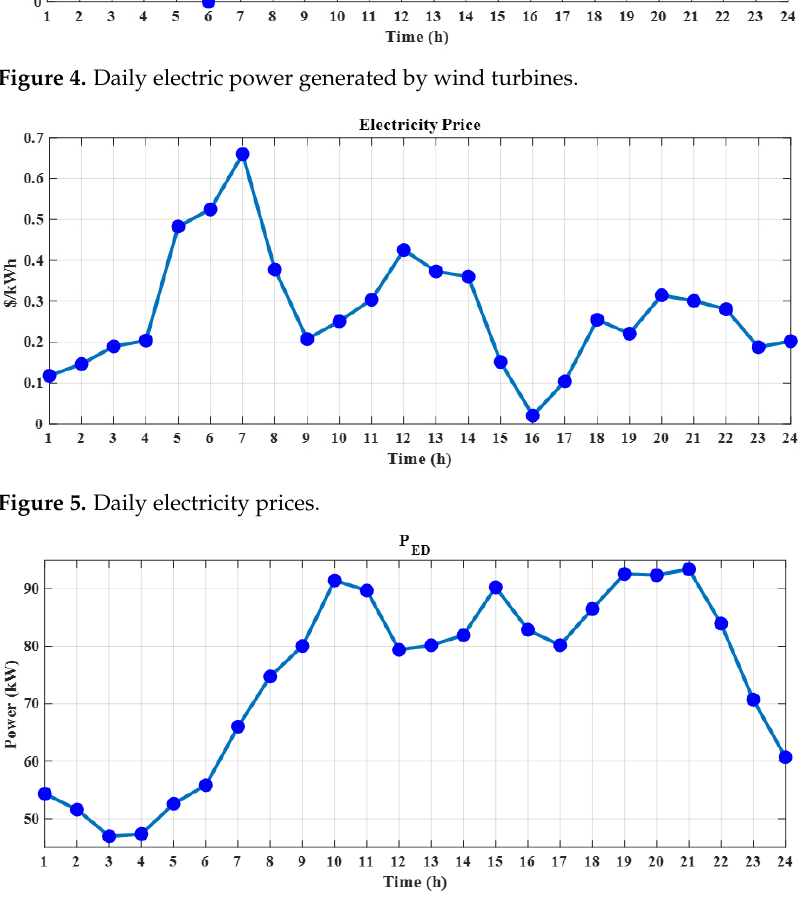
Figure 6. Daily electricity load demand.